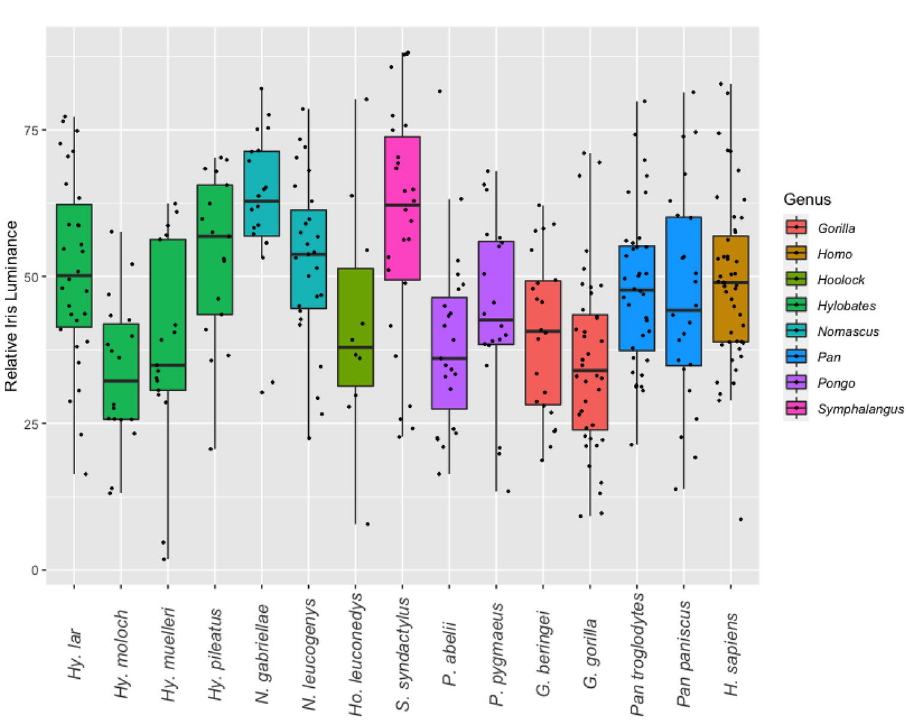
Figure. 4. Variation of relative iris luminance (RIL) in the eight extant hominoid genera at species